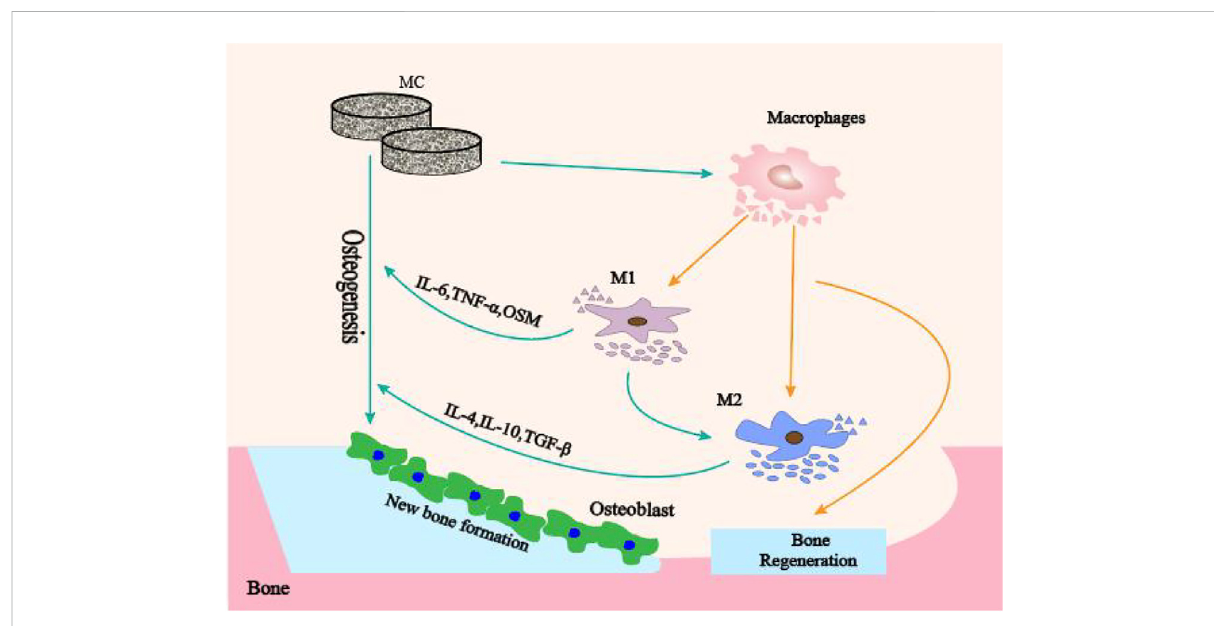
FIGURE 1 The schematic diagram of MC with different microporous structures regulating macrophage polarization to mediate